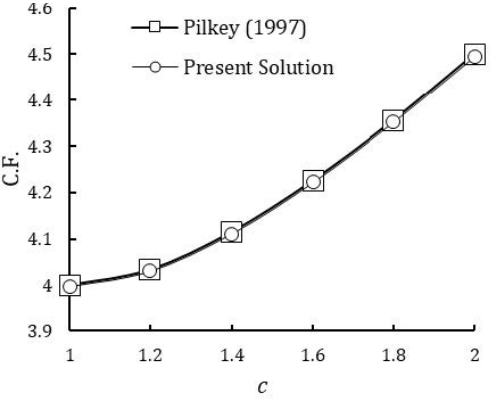
Figure 11. Variation of SCF with aspect ratio of elliptical cut out by different methods for isotropic plate ( θ 3 = 0 ◦